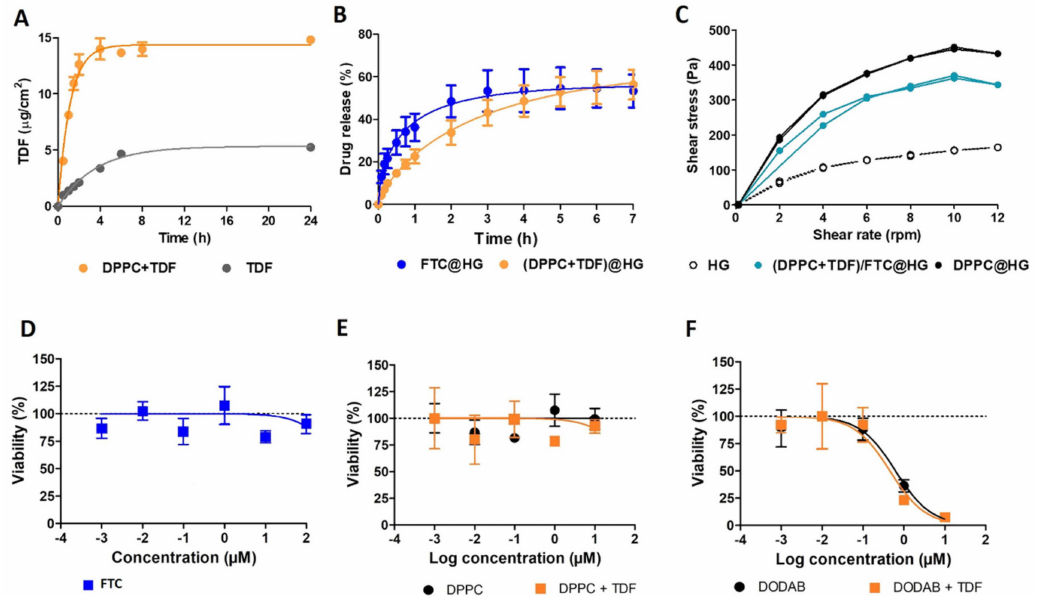
Figure 6. In vitro studies to evaluate the pharmaceutical performance of the developed formulation. In vitro TDF permeation across a polysulfone membrane in the free from (TDF) or when encapsulated in the DPPC liposomal formulation (TDF + DPPC) performed in aqueous medium at 37 ◦ C ( A ). Release profile of TDF from DPPC liposomes included in hydrogels ((DPPC + TDF)@HG) and release profile of FTC from the hydrogels (FTC@HG) performed in aqueous medium at 37 ◦ C ( B ). Flow rheograms of hydrogels without drugs or liposomes (HG), hydrogels with drug-free DPPC liposomes (DPPC@HG), and hydrogels containing FTC and TDF-loaded DPPC liposomes ((DPPC + TDF) / FTC@HG) ( C ). Viability of human HEC-1-A endometrial cell line was tested with increasing concentrations of FTC ( D ), liposomes of DPPC without drug (DPPC) or loaded with TDF (DPPC + TDF) ( E ), and liposomes of DODAB without drug (DODAB) or loaded with TDF (DODAB + TDF) ( F ). Concentrations in ( E , F ) are in TDF (real or virtual in the case of drug-free liposomes). Results are presented as mean ± standard deviation values ( n = 3). Lines in ( A , B ) and ( D – F ) represent the Weibull model and log-logistic regression fits, respectively.